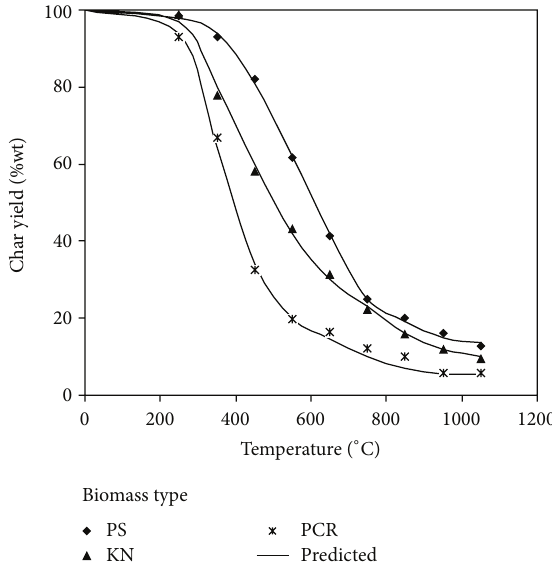
Figure 7: Char yields of biomass pyrolysis for different pyrol- ysis temperatures (particle size is 0.28 mm and N 2 flow rate is 200 cm 3